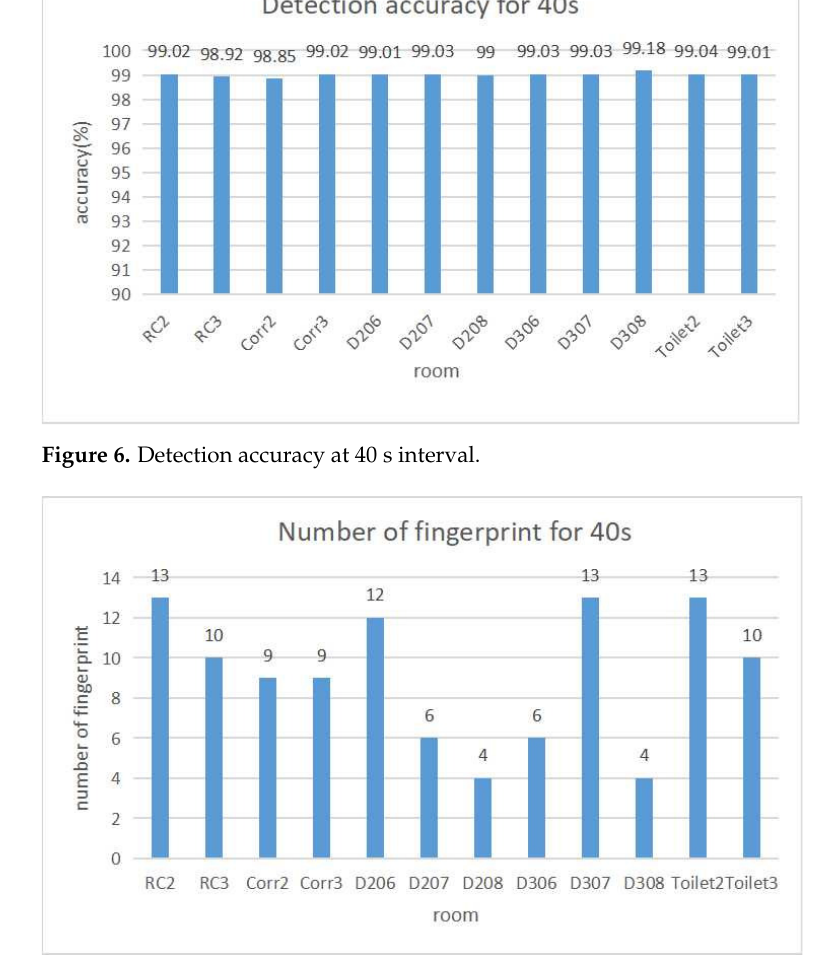
Figure 7. Number of fingerprints at 40 s